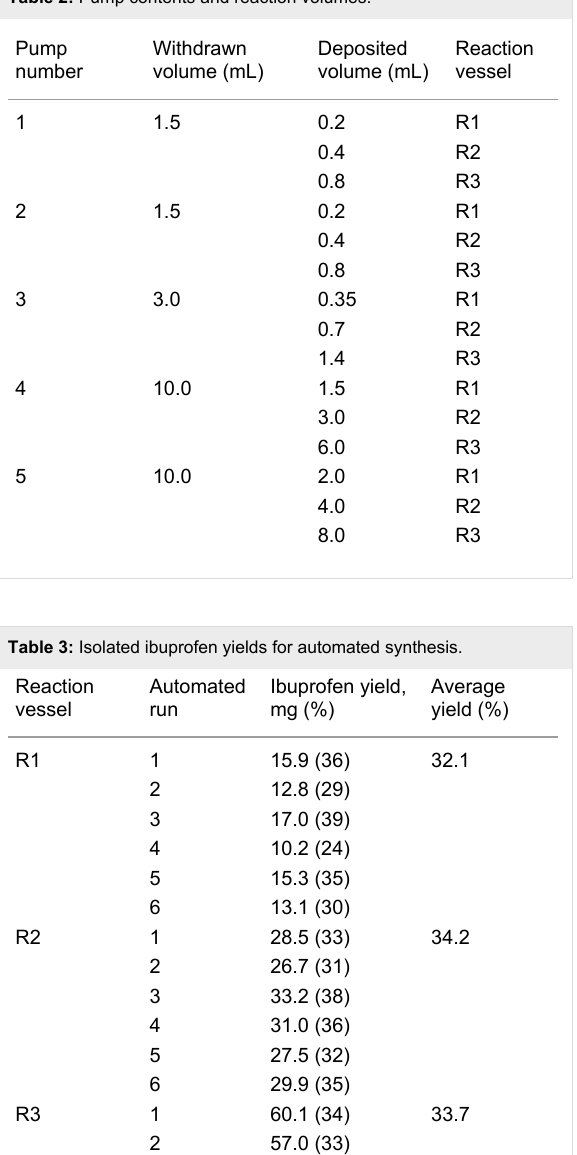
Table 2: Pump contents and reaction volumes.